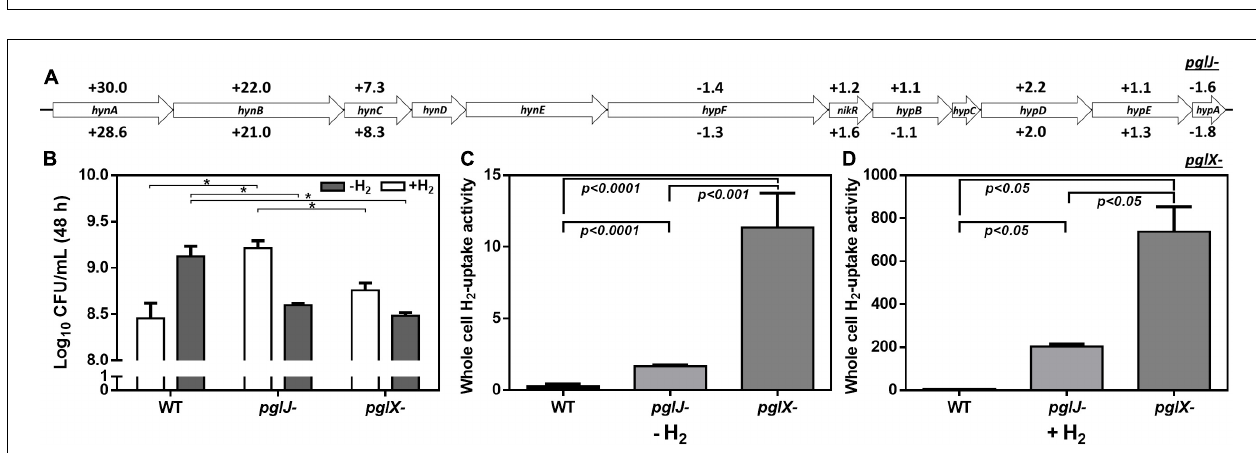
FIGURE 6 | Label-free quantification of proteins in Cff - pglJ- and pglX- strains compared to WT. (A,B) Heat maps of specific proteins with statistically significant decreases (A) or increases (B) in pglJ- and pglX- mutants compared to WT (labeled ATCC). Values are gray where MS did not identify fragments. This data represents samples from five biological replicates (B1–B5). The complete dataset is included in Supplementary Table S1 .